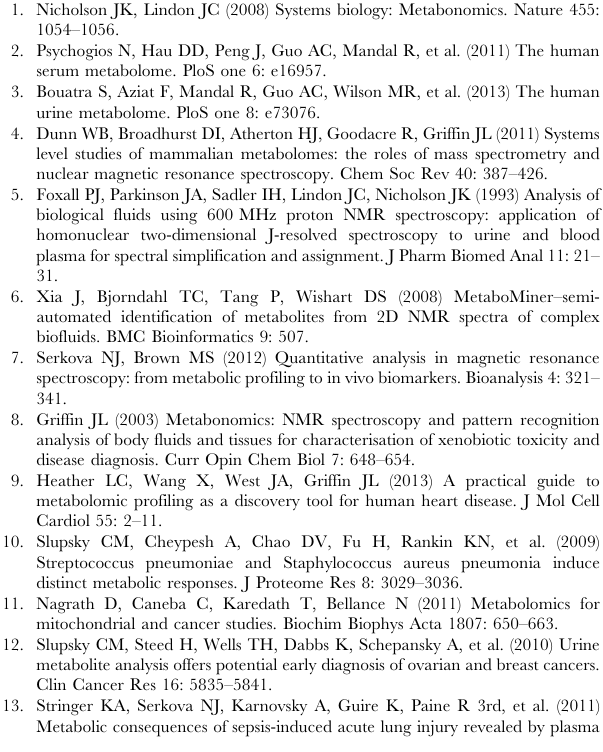
Figure S4 Representation of several NMR peak ampli- tudes relative to DSS (100%). Peaks were selected based on their frequency separations from the saturation carrier ( , 4.7 PPM). (DOCX) Figure S5 Peak heights from several 3 mm probes that were first normalized to DSS (100%) and then divided by the average amplitude of 4 separate 5 mm probe measurements. Table S1 Chemstrip 10 MD and pH data of NMR- assayed urine